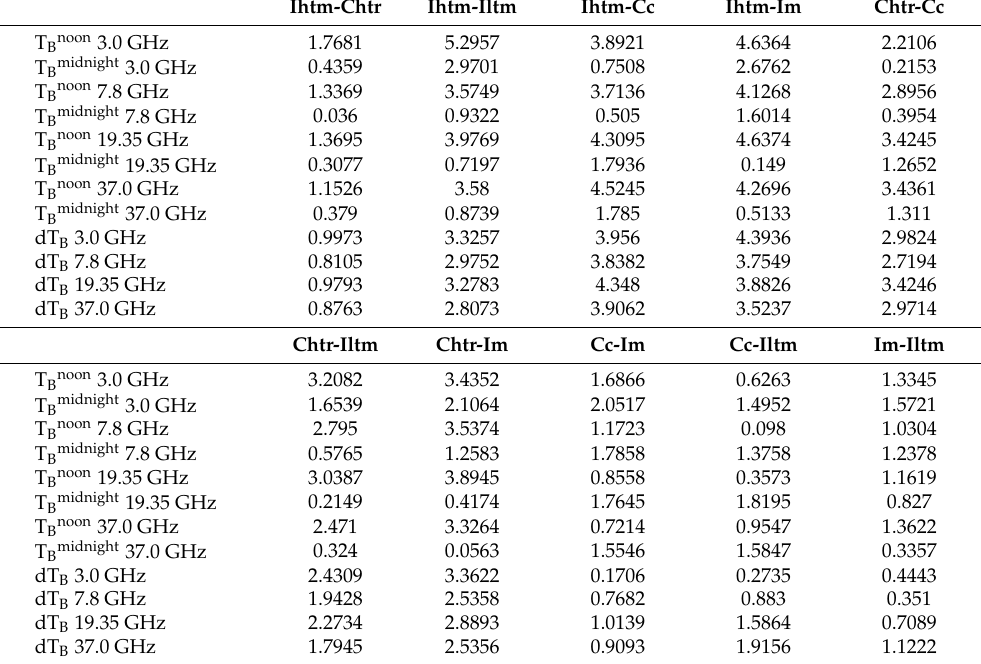
Table 1. Normalized distance between mare basalt units.